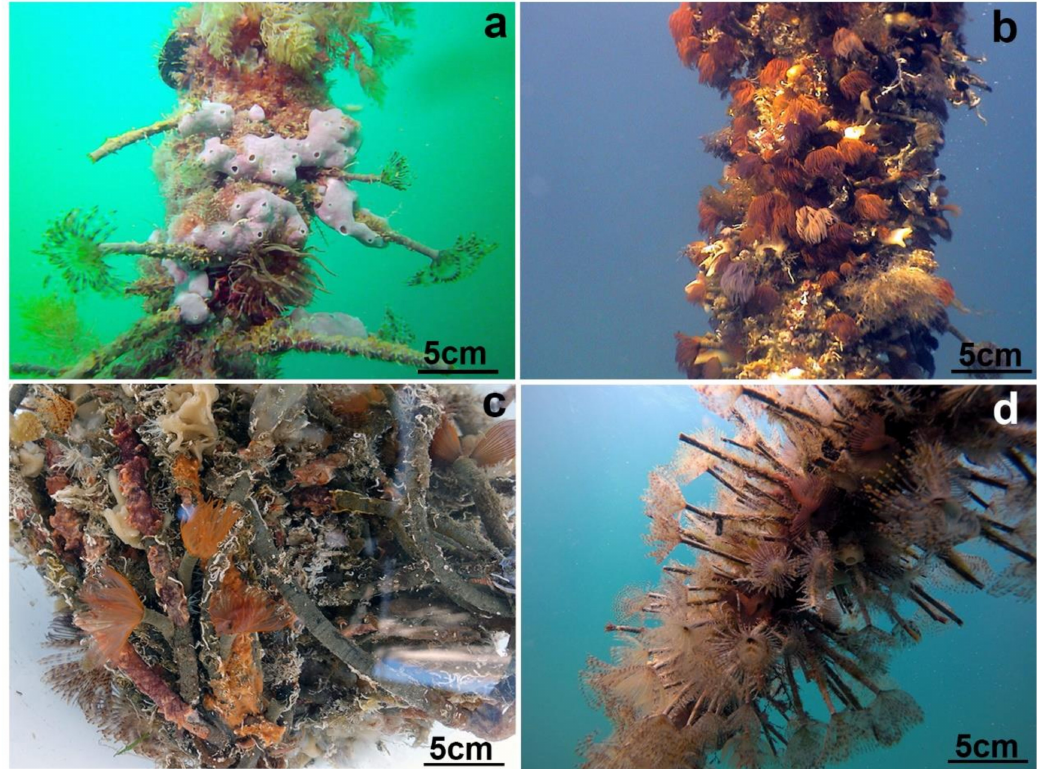
Figure 6. Fouling at the Mar Grande of Taranto, Ionian Sea, Italy: the autochthonous fan worm Sabella spallanzanii , the only dominant species thirty years ago ( a ); the allochthonous Branchiomma luctuosum ( b ); the allochthonous B. luctuosum with B. boholense , invasive for fifteen years ( c ); Sabella spallanzanii , the most abundant species nowadays ( d ). Photo credit: M. Del Pasqua, A. Giangrande and F.